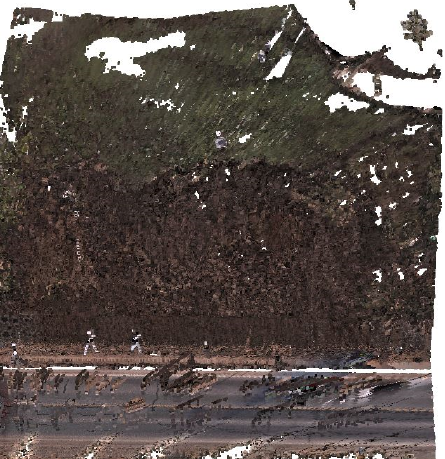
Figure 20. Landslide point cloud after the PCR of two period data.